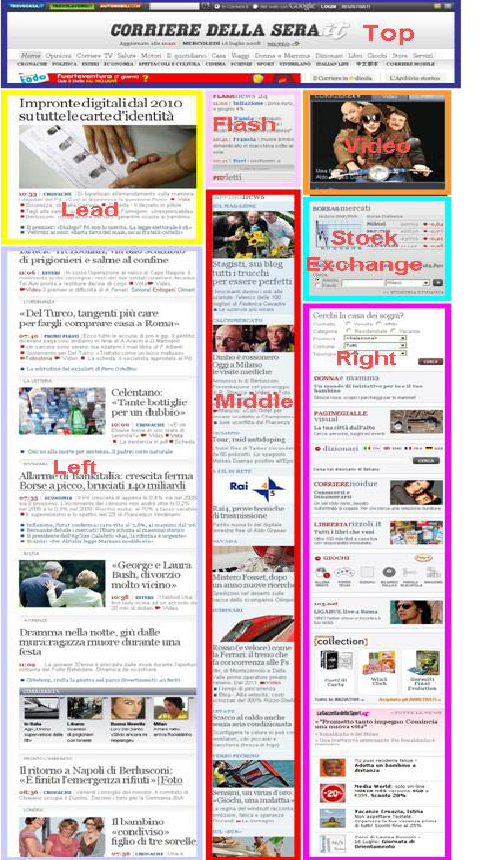
Figure 1 - Areas of Interest on Corriere della Sera home page (CS1).